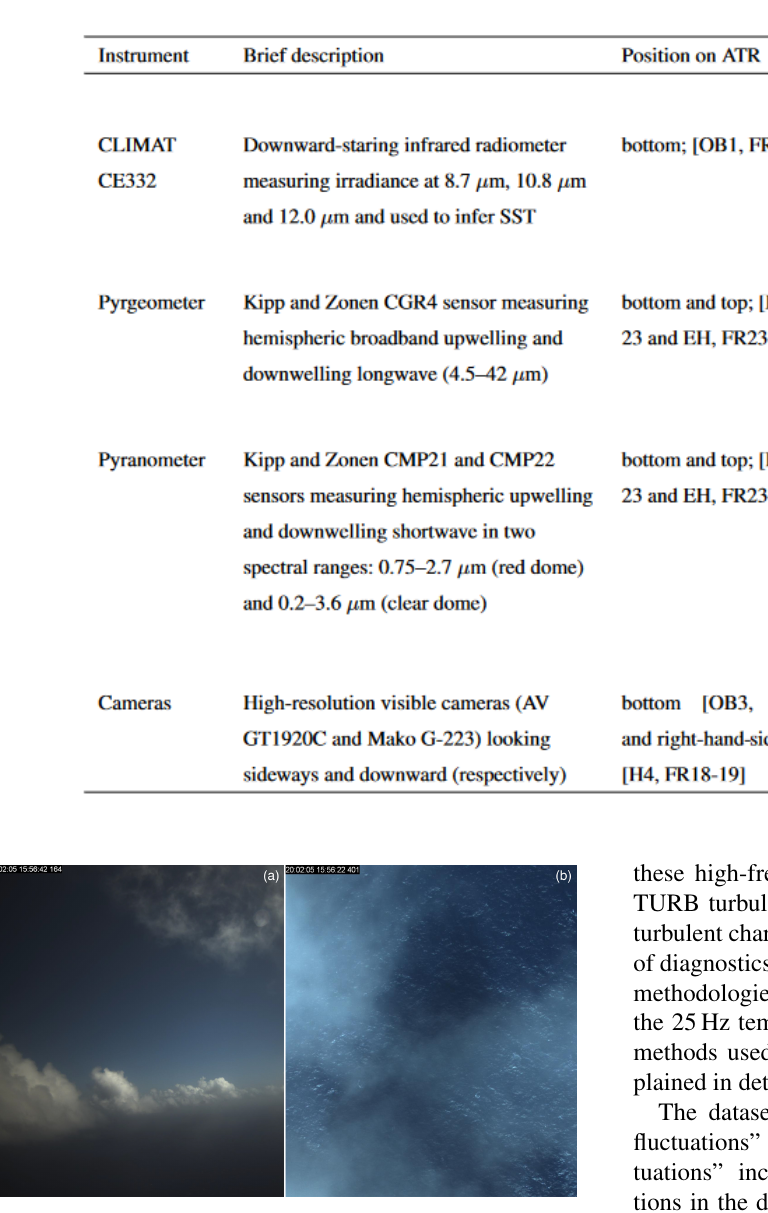
Table 7. Core instrumentation of the ATR for radiative measurements. See Appendix D for the correspondence between the position on the aircraft and the ATR configuration.